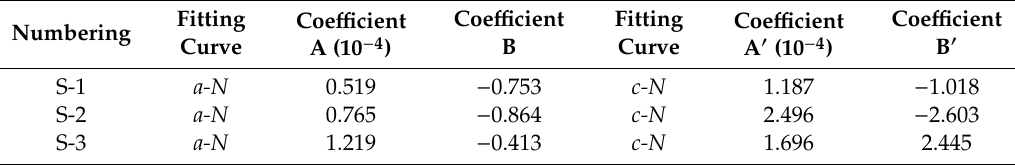
Table 8. Coe ffi cient